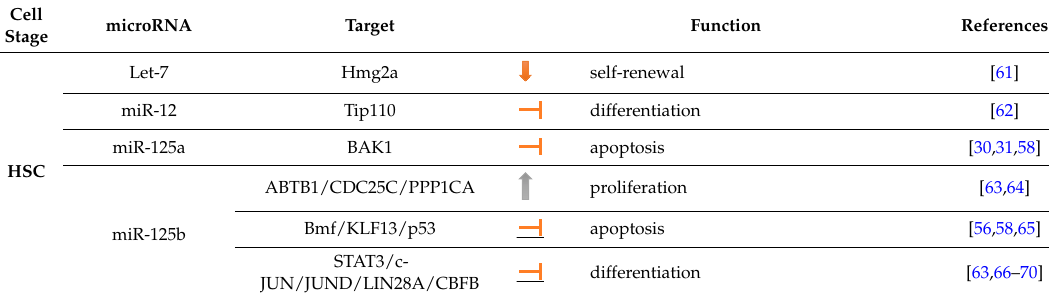
Table 1. miRNAs involved in myelopoiesis which are involved in key (stem) cell processes (differentiation, self-renewal, apoptosis and proliferation) and their identified targets.